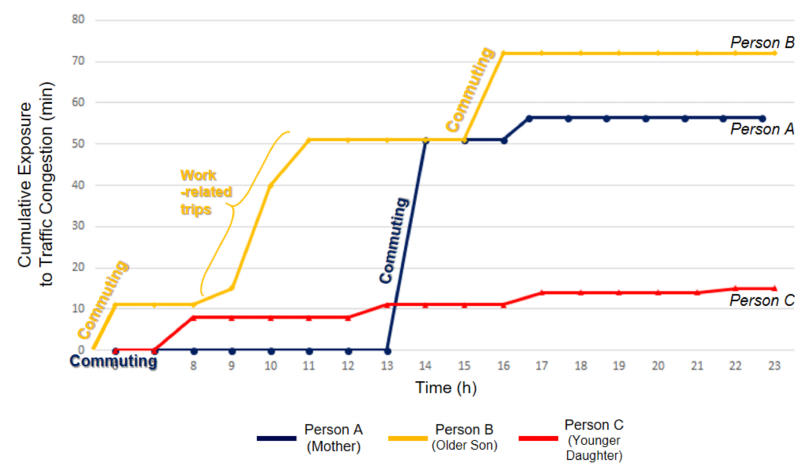
Figure 8. Cumulative exposures to traffic congestion of three selected individuals from the same household (A: Mother, B: Older Son, C: Younger Daughter).